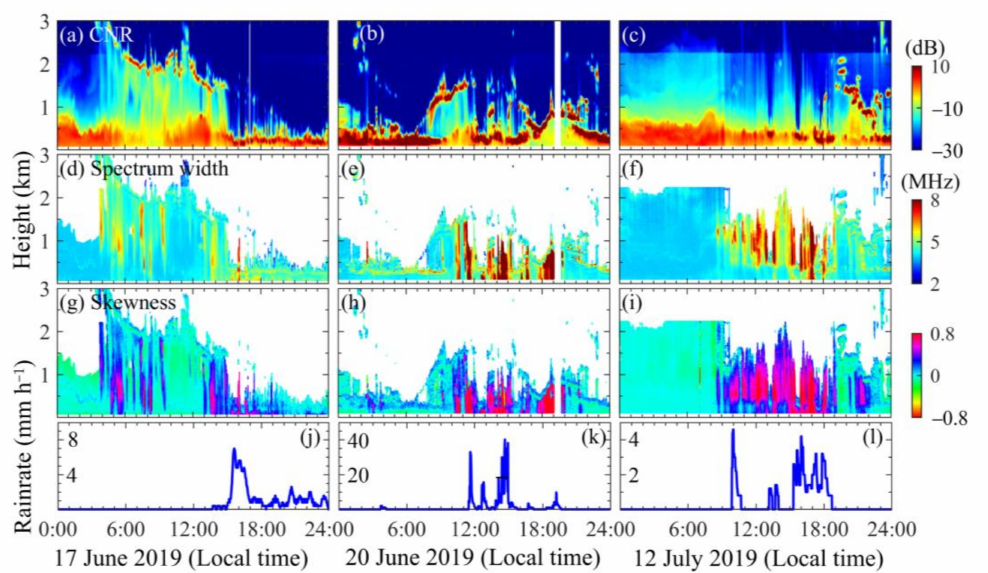
Figure 1. Precipitation processes observed by the CDWL on 17 June 2019, 20 June 2019, and 12 July 2019. ( a – c ) CNR. ( d – f ) spectrum width. ( g – i ) skewness. ( j – l ) surface rain rate provided by a Davis weather station.